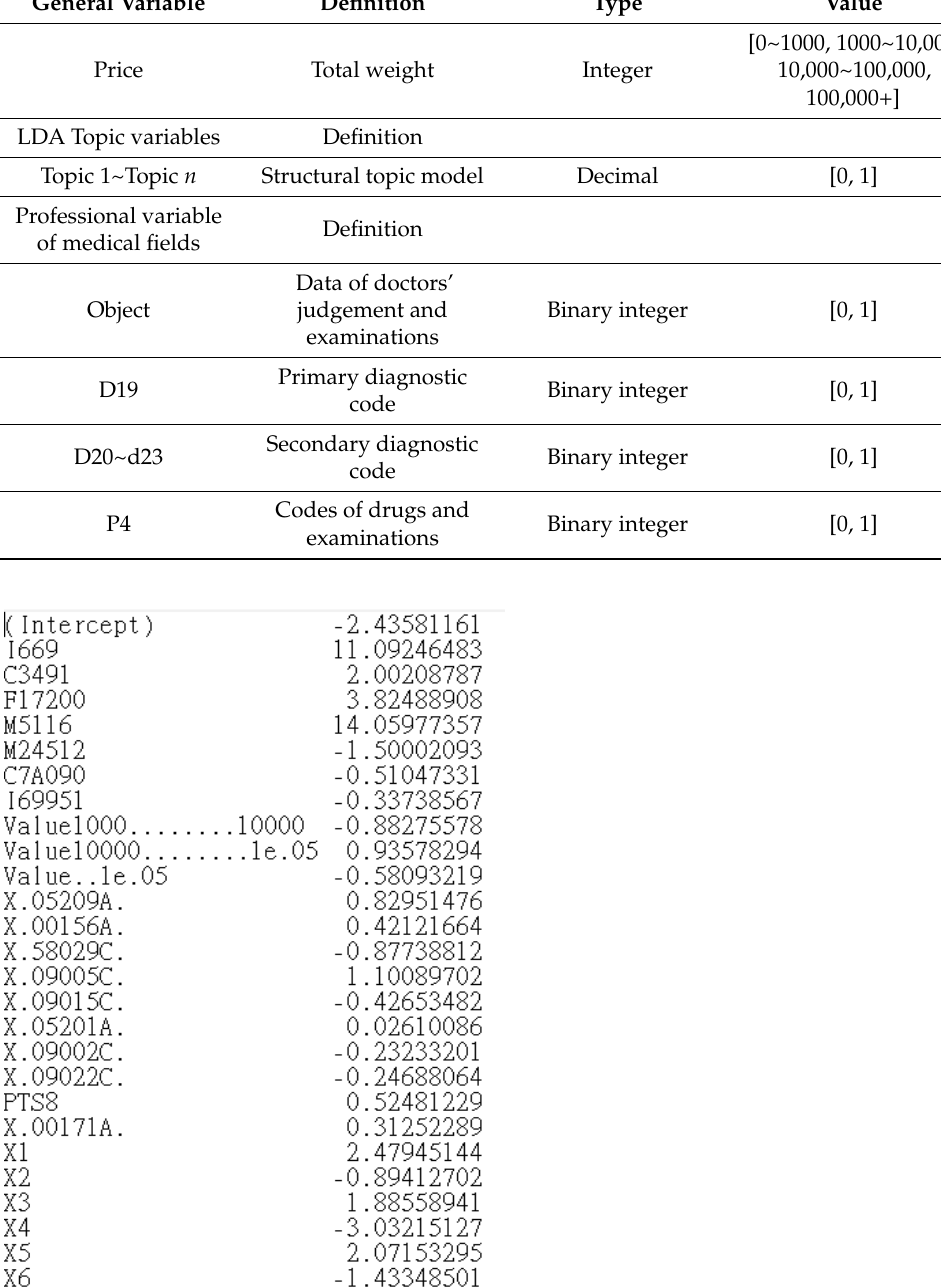
Figure 12. E11 logistic regression. 4.4. Model Performance After building the logistic regression model, the research team evaluated model per- formance for all morbid entities by using the test dataset. Table 3 refers to the model